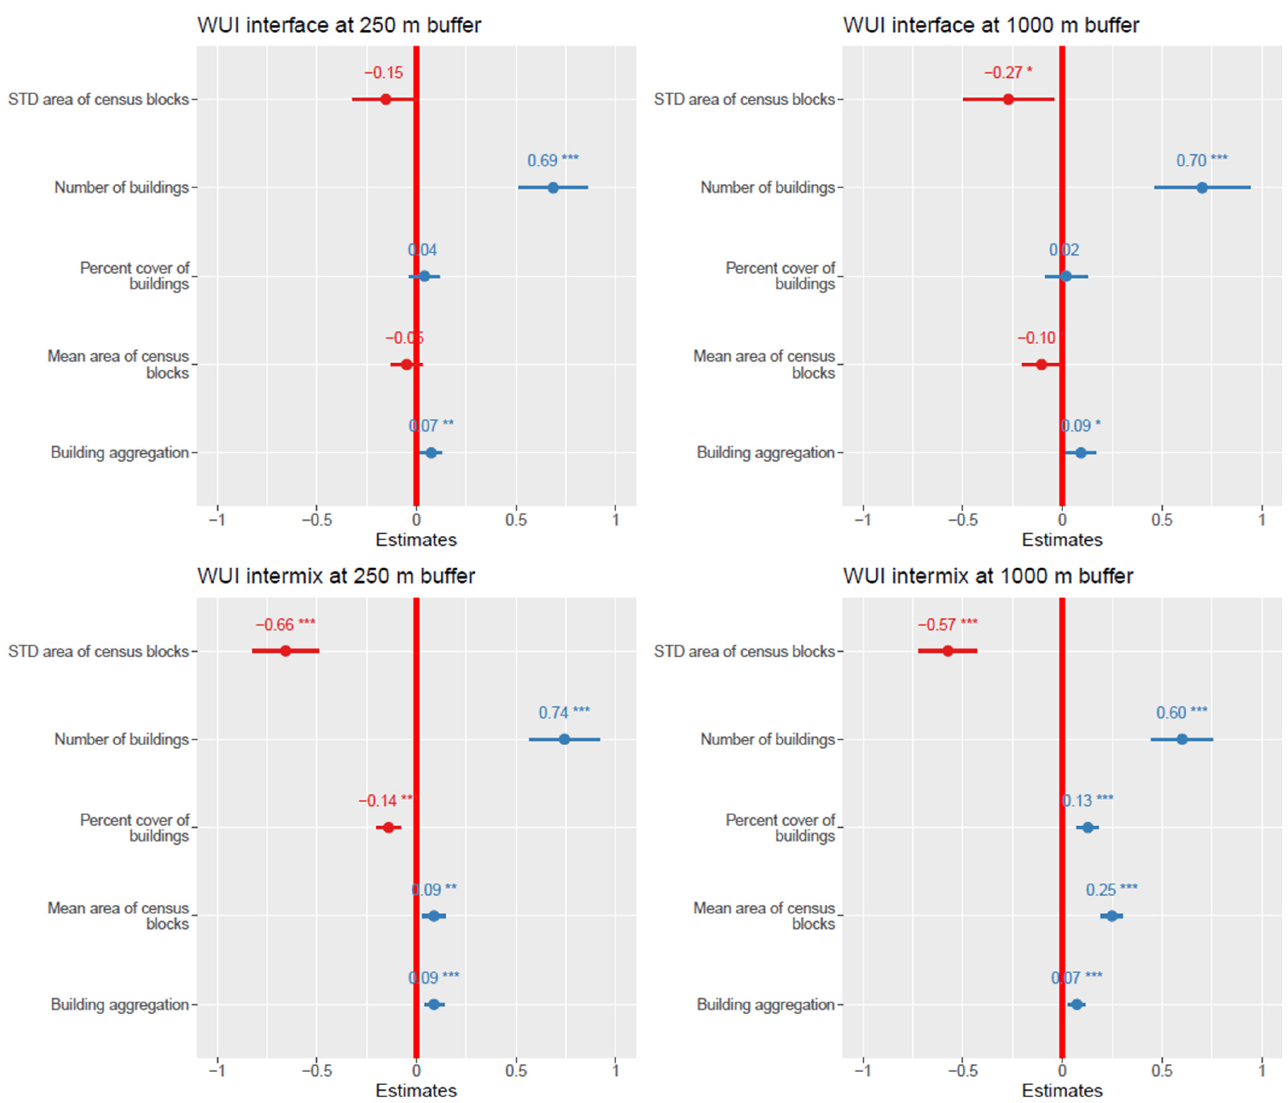
Figure 6. Standardized effect sizes of linear models for the correspondence in terms of area (point-based minus zonal-based) of zonal-based vs. point-based WUI maps. The top row is for interface WUI; whereas the bottom row is for intermix WUI. The left panels depict results of models with point-based WUI generated a 250 m buffer distance, whereas the right panels are based on 1000 m buffers. The thick red line highlights an effect of zero; a predictor whose standard error overlaps it has a non-significant effect WUI area differences. Significance levels: *** ( p < 0.001), ** ( p < 0.01), * ( p < 0.05). Model terms are explained in Section 2.4.